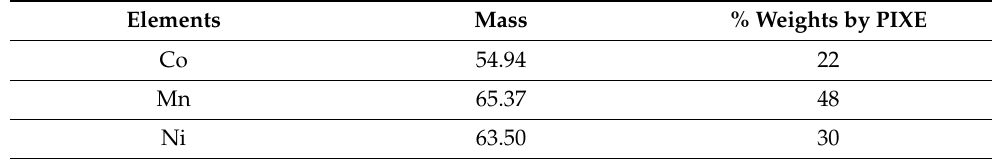
Table 2. PIXE spectra parameters for Pristine Co 3 O 4 @MnO 2 @NiO/GO